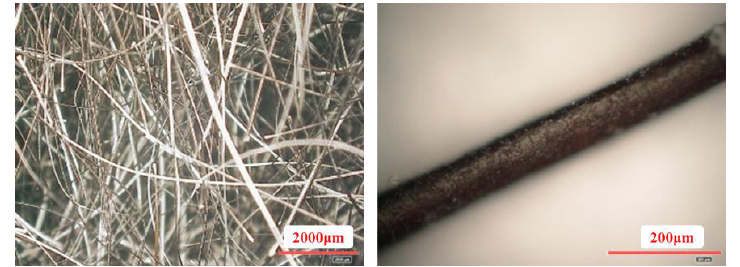
Figure 1. Photos of CHF under different magnifications.